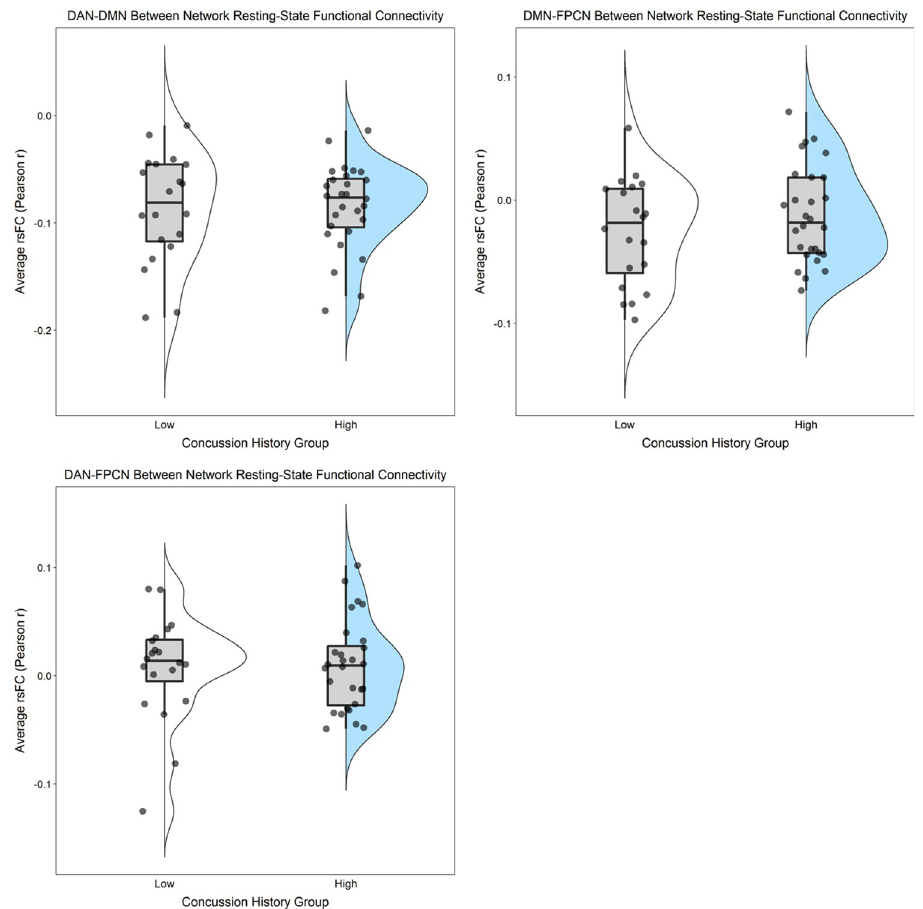
Fig 2. Between-network resting-state functional connectivity (rsFC) in large-scale networks separated by dichotomous concussion history group. Between-network rsFC was calculated as the average Pearson r correlation (y-axes) between each of the individual ROIs from one specific network and all individual ROIs in another specific network across the time-series: Dorsal Attention Network and Default Mode Network (top-left); Default Mode Network and Frontoparietal Control Network (top-right); and Dorsal Attention Network and Frontoparietal Control Network (bottom). Individual points represent participant-level outcomes for each measure within each of the concussion history groups (White = “Low” [fewer than 3 lifetime concussions]; Blue =“High” [3 or more lifetime concussions]). Boxplots represent the median and interquartile range, and the whiskers extend to 1.5 times the interquartile range. The violin plot is a depiction of the density of individual rsFC values for each